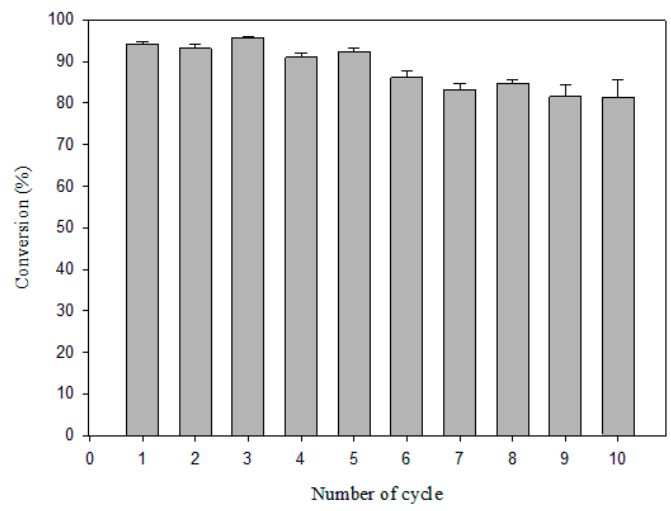
Figure 5. Reusable cycles of Novozym ® 435 in the synthetic process of octyl ferulate under indicated